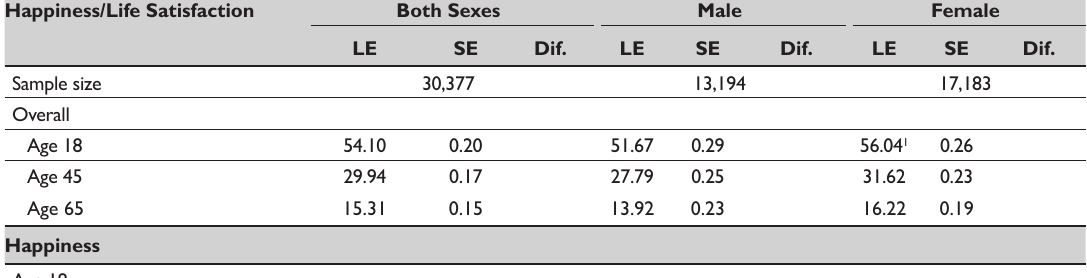
Happiness Age 18 None / a little of the time